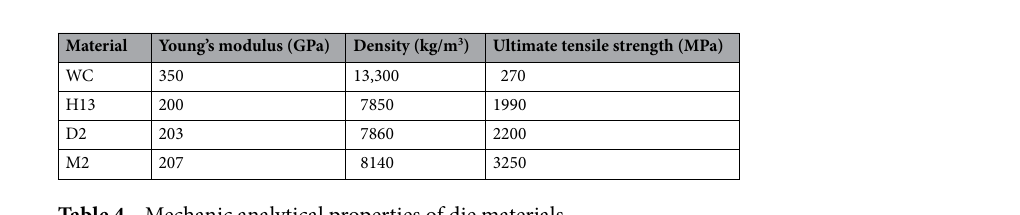
Table 4. Mechanic analytical properties of die